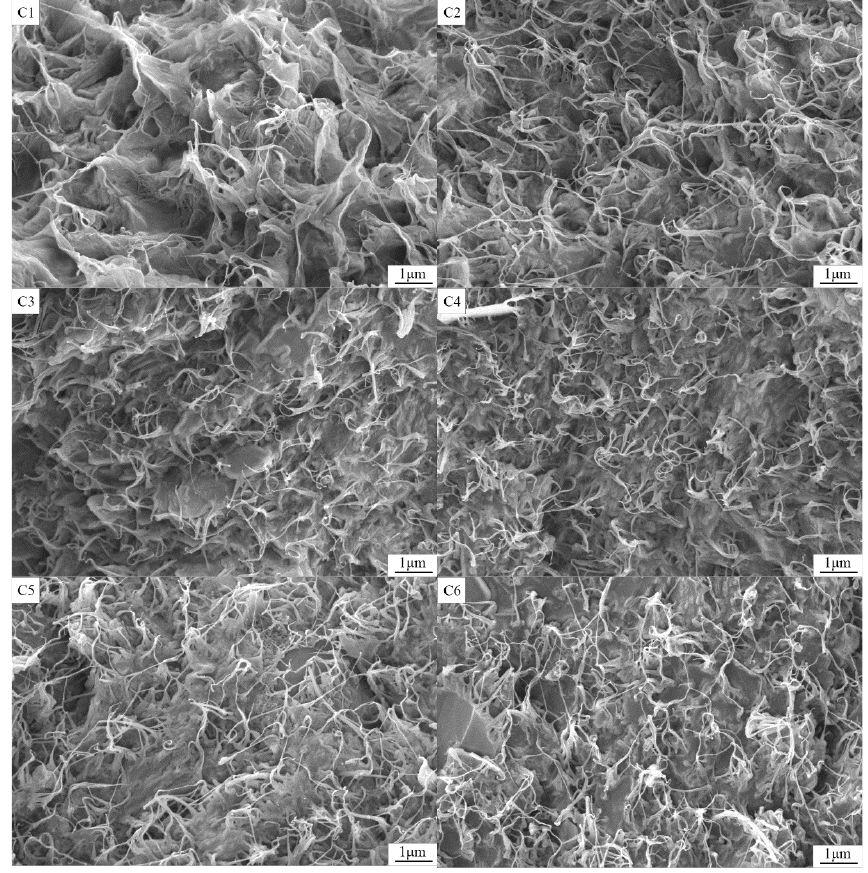
Figure 2. SEM images of CNT/PE-EPDM/EG-based phase change composites (C1~C6).